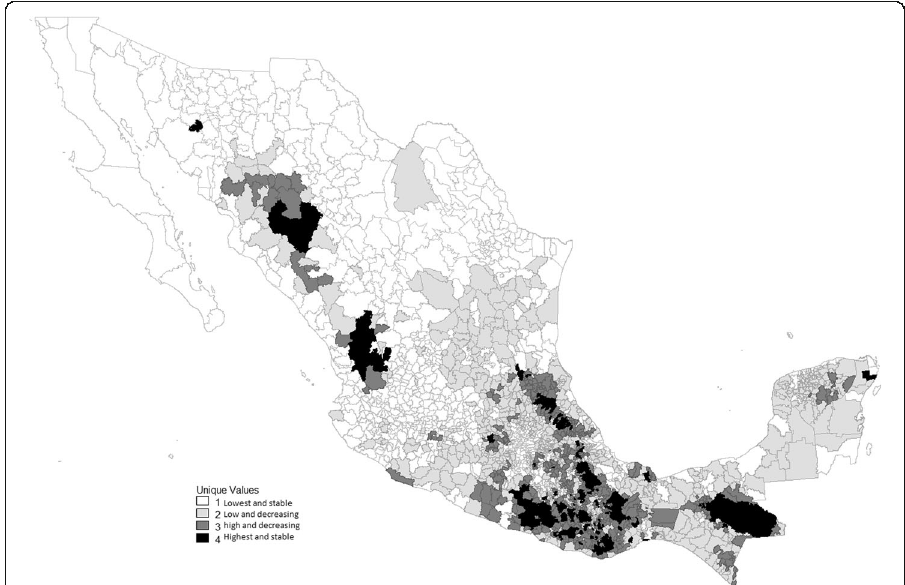
Fig. 5 Four longitudinal trajectory classes of social lag Mexico 2000 – 2015.Note: lowest and stable (class 1), low and decreasing (class 2), high and decreasing (class 3), and highest and stable (class 4). Source: Own elaboration using Census Bureau data 2000-2015